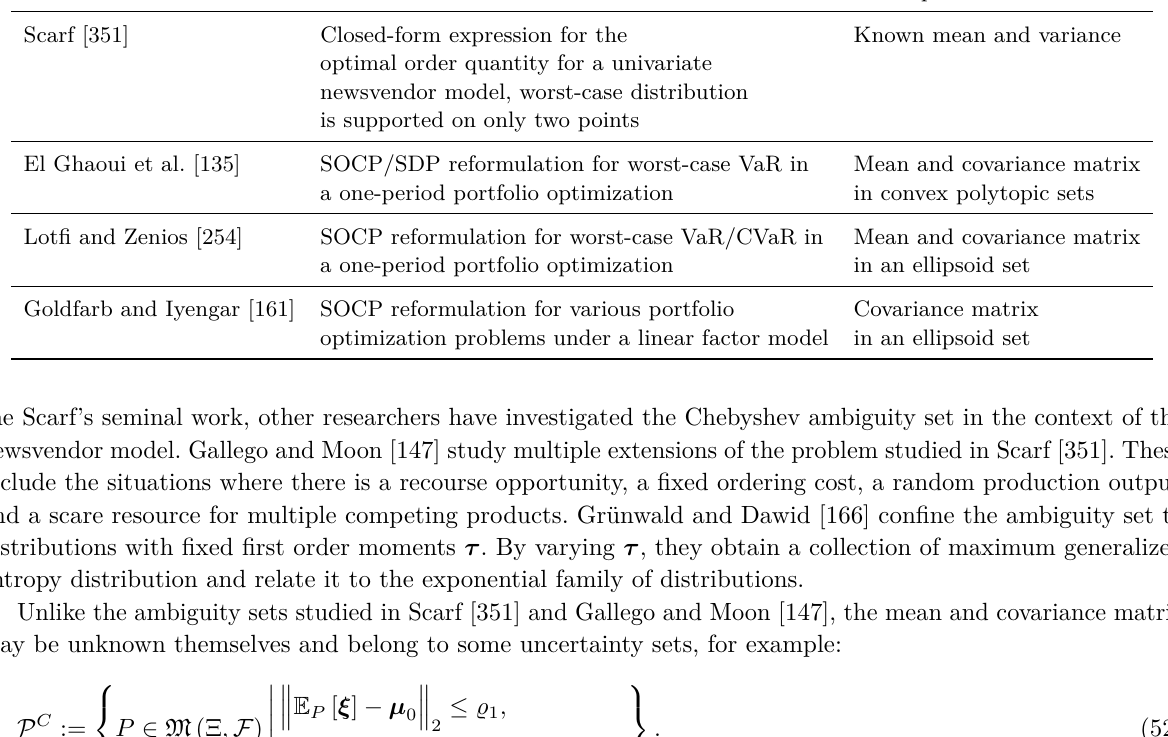
Known mean and variance Mean and covariance matrix in convex polytopic sets Mean and covariance matrix in an ellipsoid